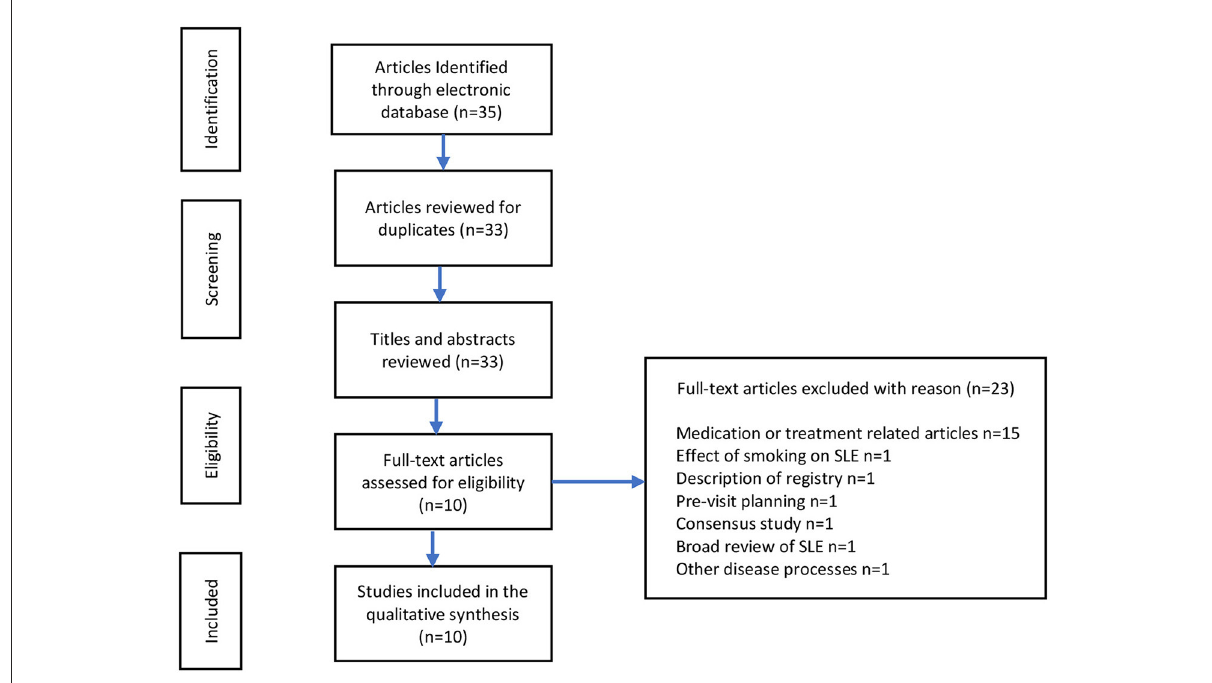
FIGURE1 Flow chart for PubMed query for pediatric SLE, health disparities, and patient